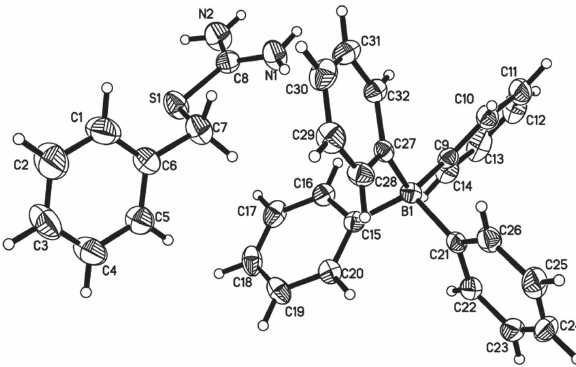
Table 2: Fractional atomic coordinates and isotropic or equivalent isotropic displacement parameters (Å 2